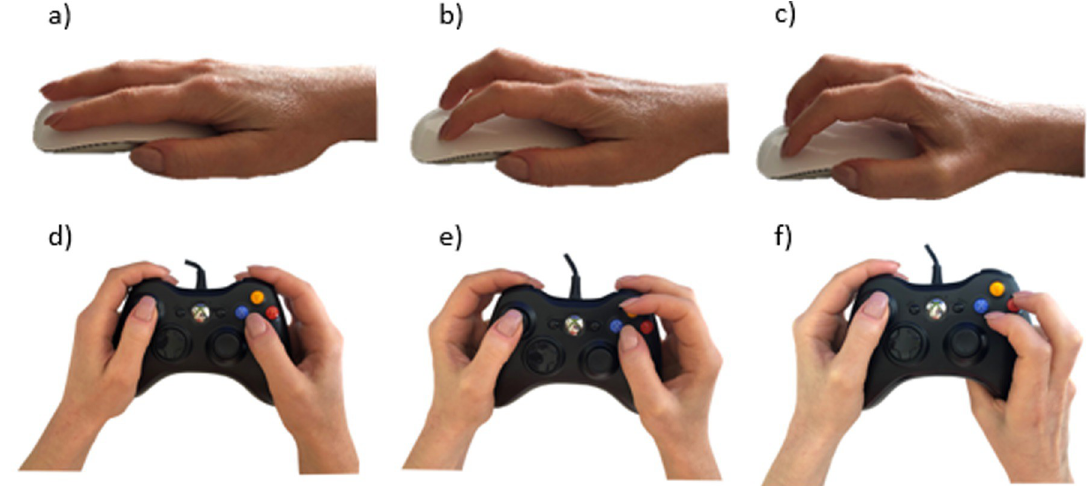
Fig 5. Selected grip techniques in gaming (copyright: Authors). Top row: mouse operations—a—palm; b—claw; c—fingertip; bottom row: gamepad operations d—normal; e—Rocket League; f—action/fight.